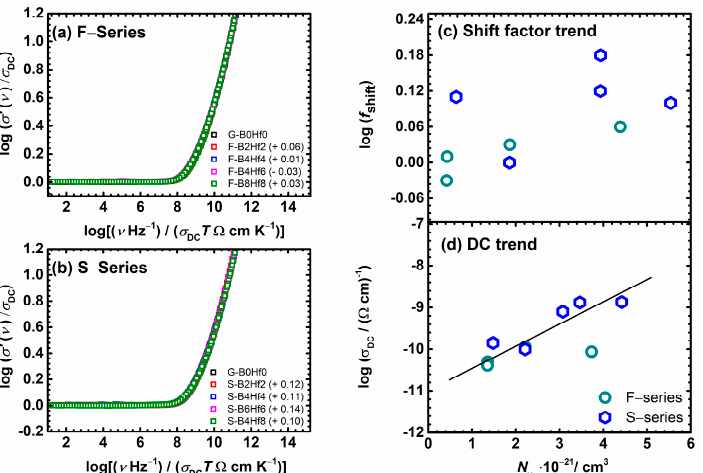
Figure 6. Individual master-curves shifted along the x -axis to overlap with the reference master-curve of base glass G–B0Hf0 for ( a ) F– and ( b ) S–glass series. The shift factors in the logarithmic scale, log( f shift ), for all samples are indicated in the legends and listed in Table 3. Plots of ( c , d ) log DC conductivity at 30 °C, and log( f shift ) from Summerfield scaling as a function of the number density of charge carriers, N v , for all samples studied.